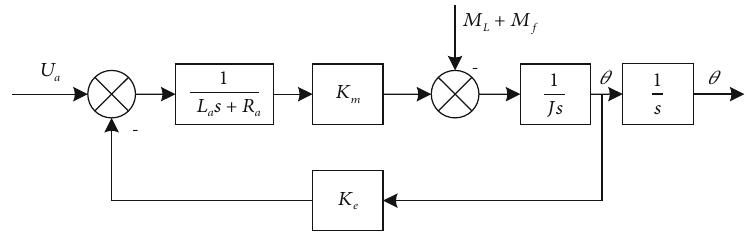
Figure 7: System block diagram of the motor including the system and the working load torque.